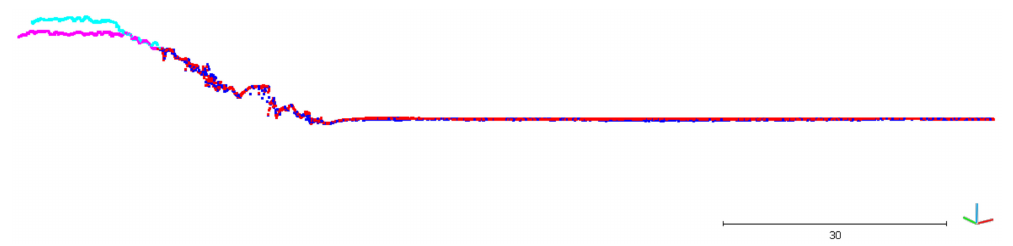
Figure 14. Zoom of the section cloud relative to section trace number